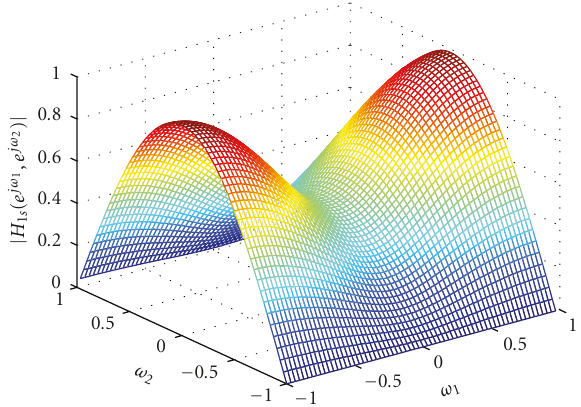
Figure 6: Normalized magnitude H 1 s ( e jω 1 , e jω 2